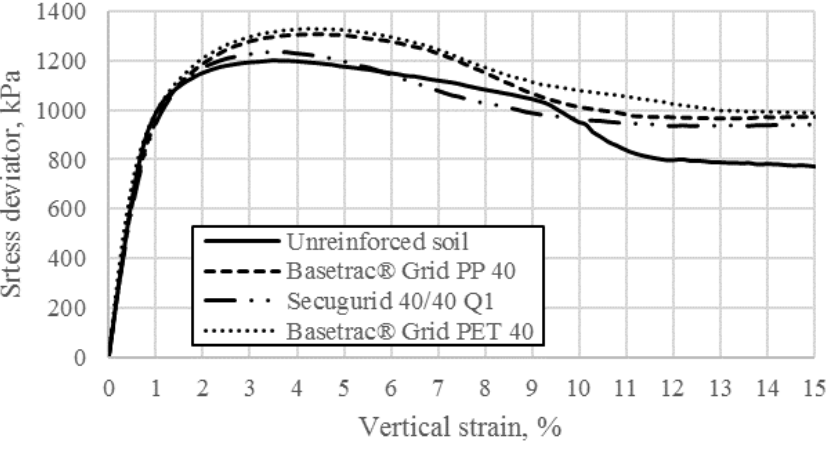
Figure 6: Dependence of stress deviator on the vertical strain of unreinforced and reinforced soil samples with geogrids when the cell pressure σ = 300 kPa. 3